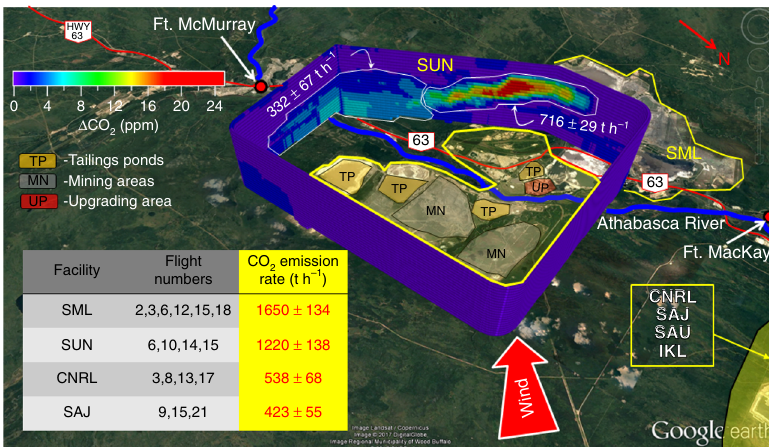
Fig. 1 Measured CO 2 from fl ight 15 around the SUN facility. Mass emission rates have been determined for this facility using the TERRA algorithm, where elevated and surface emissions can be quanti fi ed separately. The mean hourly CO 2 emission rates (t h − 1 ) during all fl ights covering the four major surface mining operations in the oil sands are shown in the inset table. Uncertainties represent the standard error σ ffiffiffi